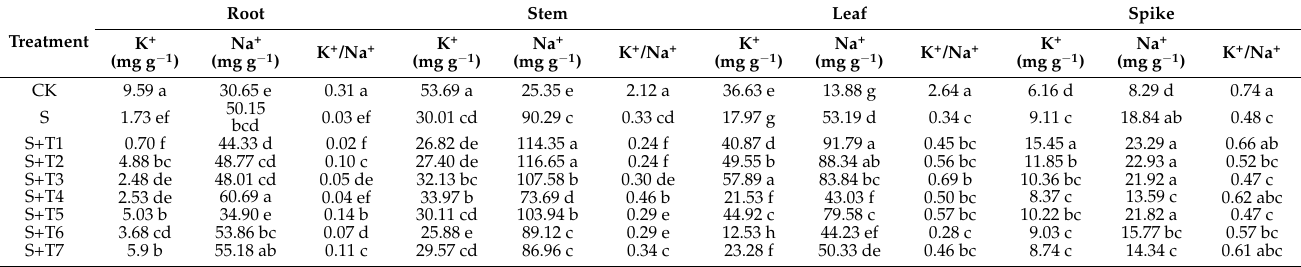
Table 9. Na + and K + content in rice organs at full-ripening